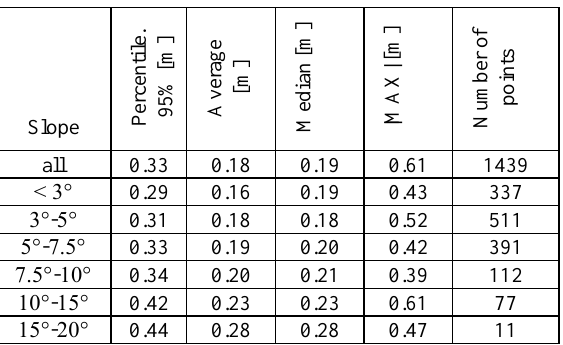
Figure 6. Distribution of deviation absolute values and regression line (points on micro-relief objects excluded)